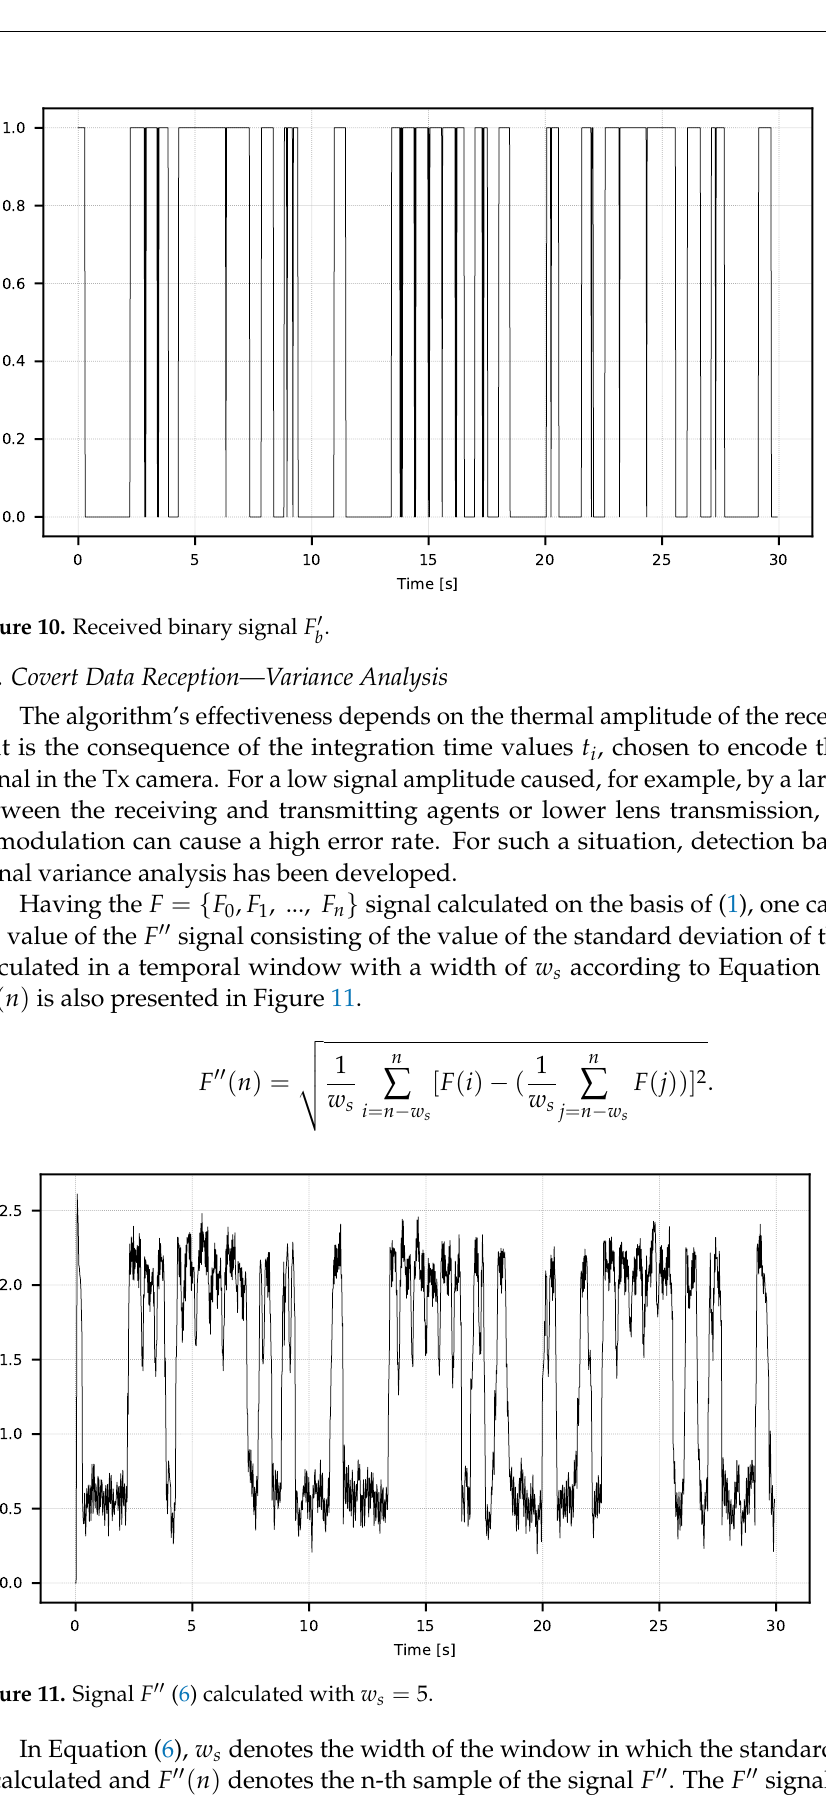
In Equation (6), w s denotes the width of the window in which the standard deviation is calculated and F (cid:48)(cid:48) ( n ) denotes the n-th sample of the signal F (cid:48)(cid:48) . The F (cid:48)(cid:48) signal should